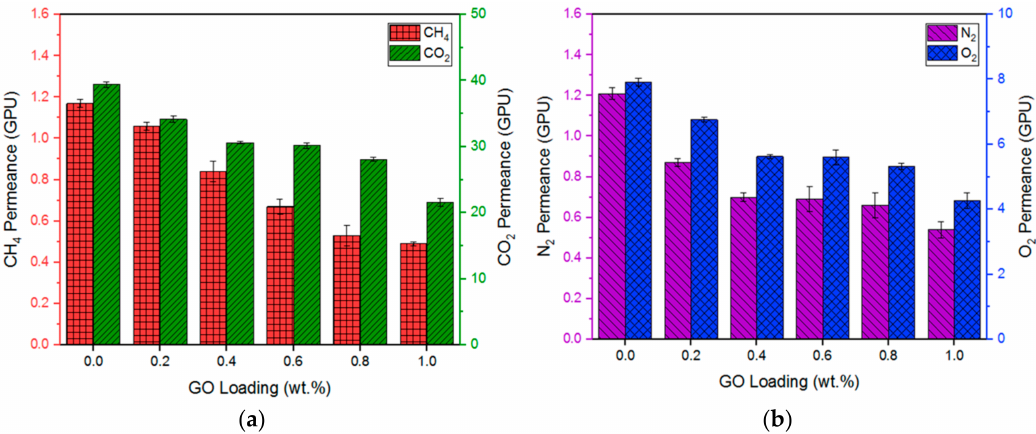
Figure 7. Pure gas permeance of multilayer-coated membranes with di ff erent GO loadings at 5 bar: ( a ) CH 4 and CO 2 and ( b ) N 2 and O 2 .